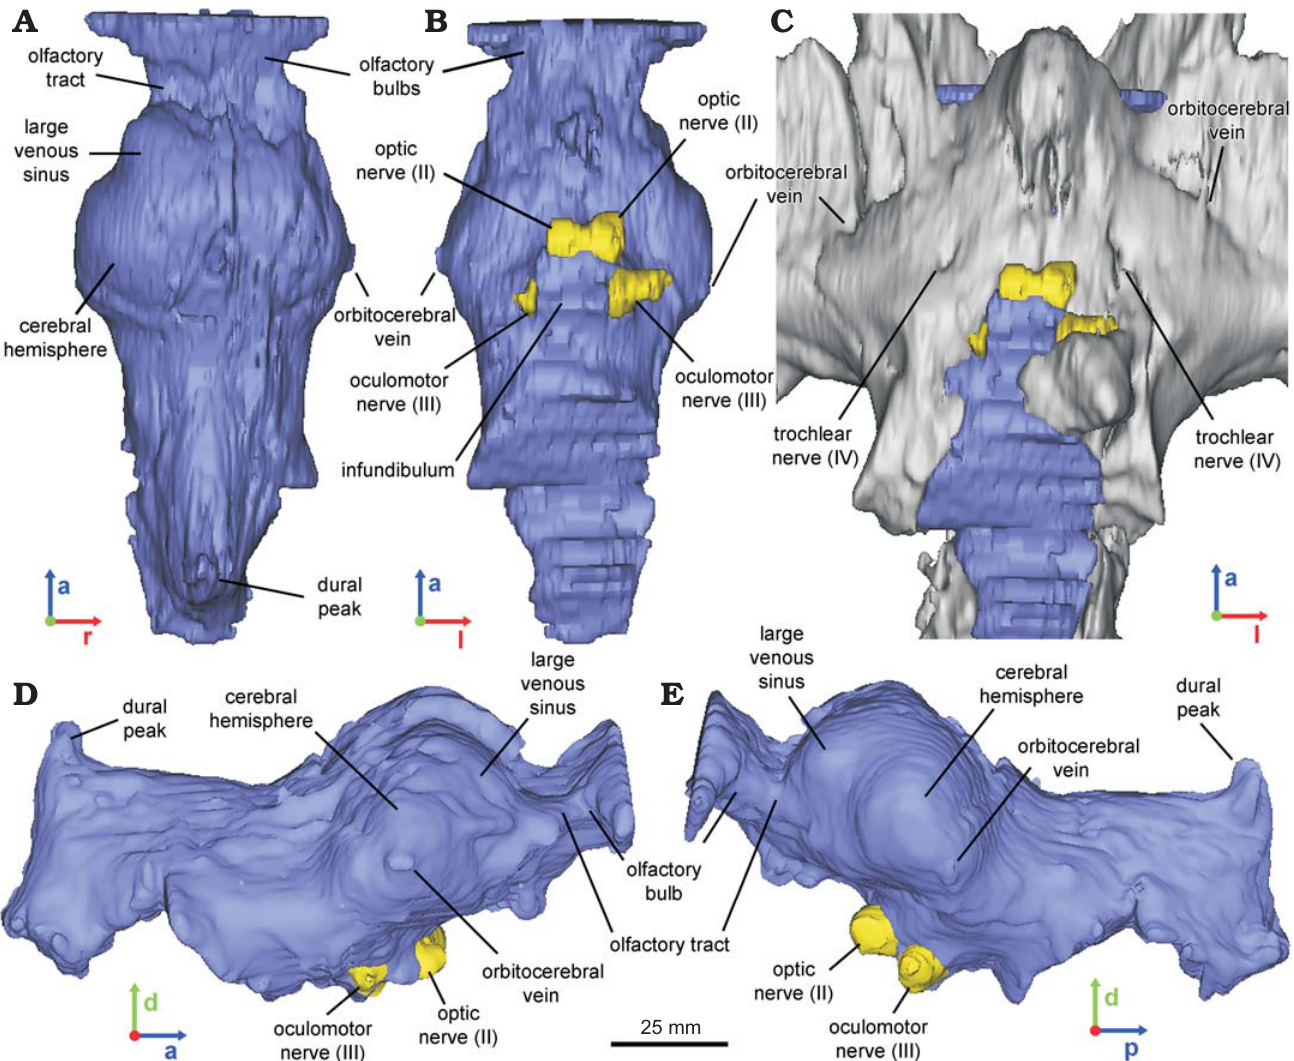
Fig. 2. Reconstructed endocast of braincase of the hadrosaurid dinosaur Secernosaurus koerneri Brett-Surman, 1979 (MACN-RN 144) from the late Campanian–early Maastrichtian, Los Alamitos Formation of North Patagonia; in dorsal ( A ), ventral ( B ), left ( D ), and right ( E ) views, with a ventral view of both the fossil specimen and the endocast ( C ). Blue, encephalon; gray, braincase; yellow, foramina of the cranial nerves. Abbreviations: a, anterior; d, dorsal; l, left; p, posterior; r, right.